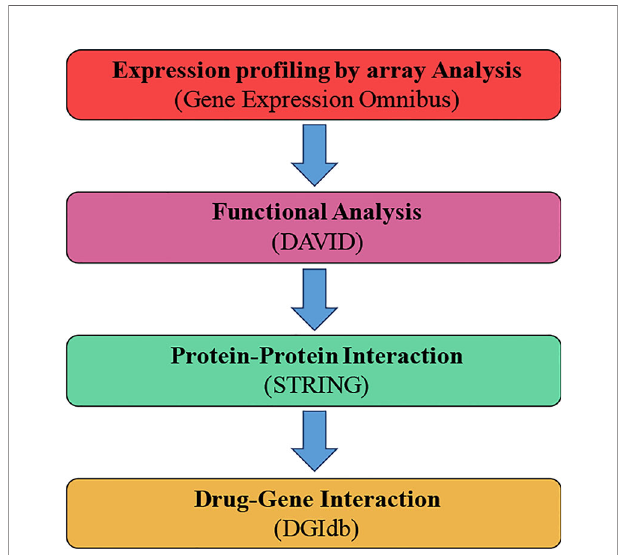
FIGURE 1 | General text mining approach. The data mining was expanded to distinguish genes connected with osteoarthritis (OA) and patients without osteoarthritis (marked control) (N-OA), using the Gene Expression Omnibus. The obtained genes were investigated for their function and gene pathway using GO and KEGG. The enrichment was attained by PPI with STRING. The fi nal enriched gene list was identi fi ed using the